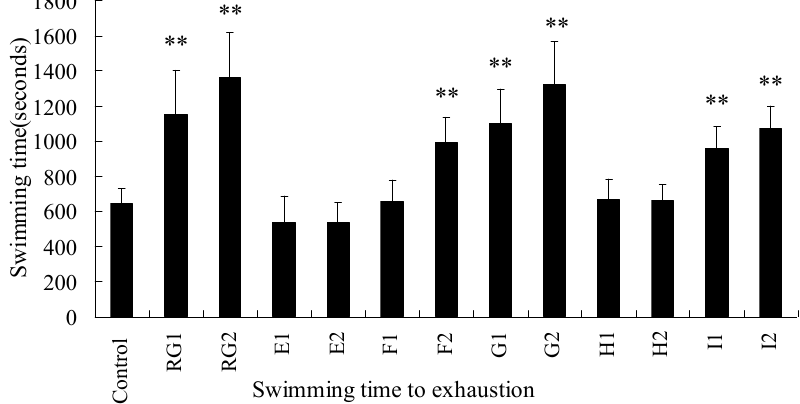
** indicates statistically significant difference as compared to the control group ( p < 0.01). Figure 3. The effects of n-butanol fractions on the swimming time to exhaustion of weight-loaded mice. RG1: low dose of red ginseng, RG2: high dose of red ginseng, E1: low dose of water eluate, E2: high dose of water eluate, F1: low dose of 20% ethanol eluate, F2: high dose of 20% ethanol eluate, G1: low dose of 50% ethanol eluate, G2: high dose of 50% ethanol eluate, H1: low dose of 100% ethanol eluate, H2: high dose of 100% ethanol eluate, I1: low dose of 100% ethanol eluate, and I2: high dose of 100% ethanol eluate. The fractions were collected from D101 macroporous resin. Low dose denotes 10 mg/kg per mouse, and high dose denotes 20 mg/kg per mouse. I1 and I2 represent animals treated with nigaichigoside F1 at 2 mg/kg and 4 mg/kg, respectively.